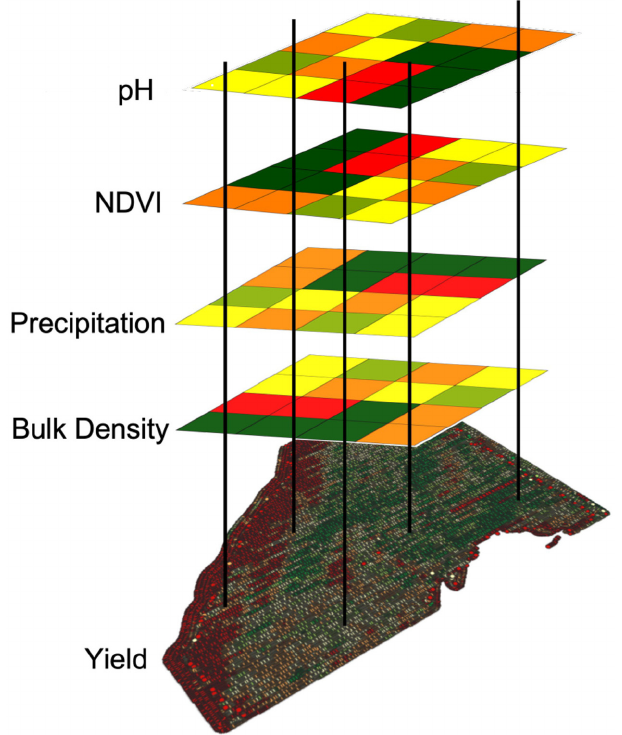
Figure 2. Conceptual diagram of the aggregation process. Grids with a 10 m resolution were overlayed on each field, and all data collected on farms and from remotely sensed information were aggregated to the centroid of each 10 m grid cell. As-applied or as-planted data were also aggregated to the centroid of grid cells via a spatial intersection of the grid points and the experimental data. The aggregation process resulted in datasets on a 10 m scale for each field, and contained the crop responses, experimental rates, and all remotely sensed covariates. In this example, measurement values for a sample set of cells of remotely sensed raster data (pH, NDVI, precipitation, and soil bulk density) were georeferenced to grain yield points via spatial intersection (represented by the vertical lines).